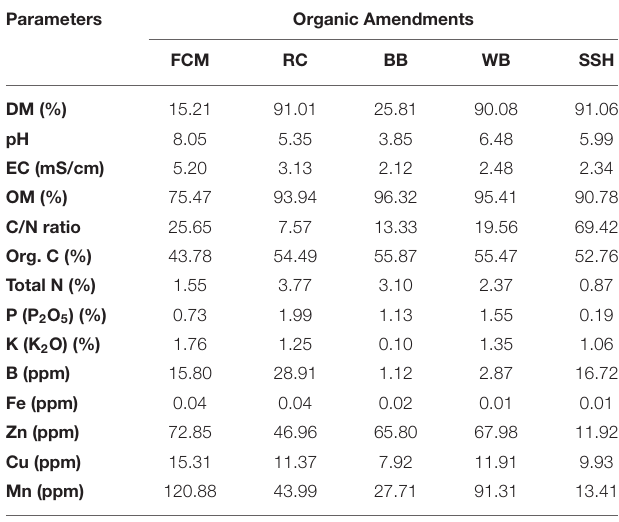
TABLE 1 | Physicochemical values (DM, dry matter; OM, organic matter) of the organic amendments used for the biodisinfestation treatments: FCM (fresh cow